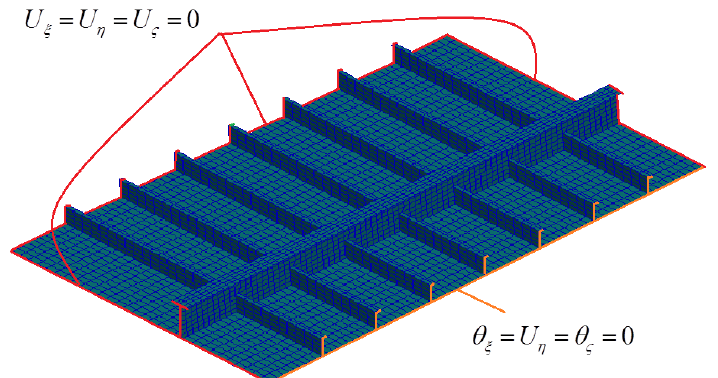
Figure 4. Boundary conditions of the stiffened panel.